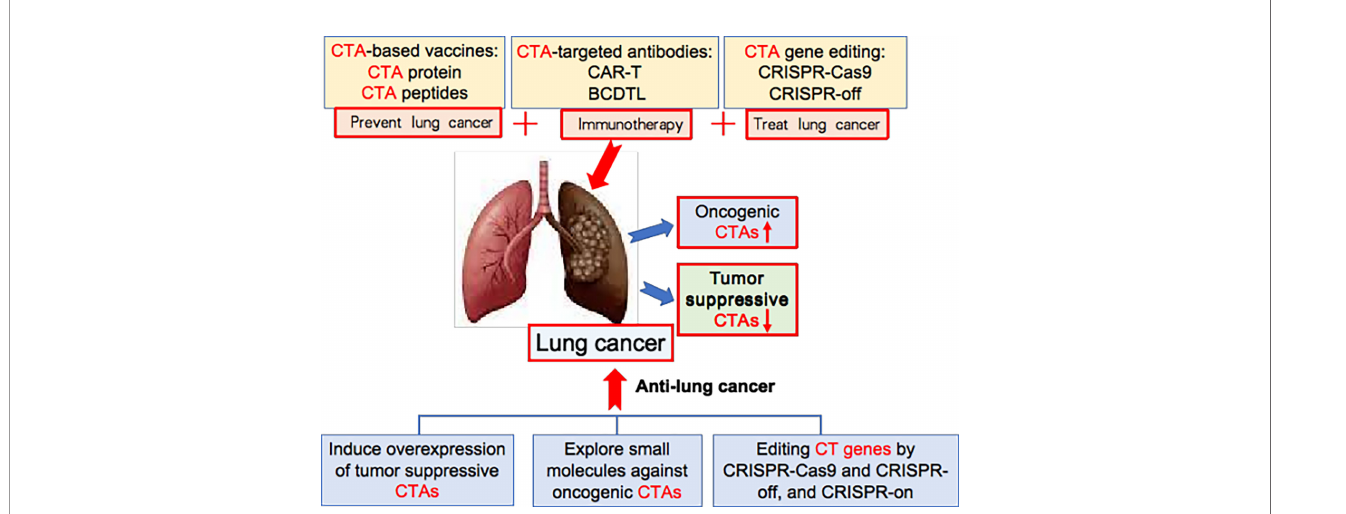
FIGURE 3 | New strategy for CTA-based lung cancer therapy. The oncogenic CTAs are abnormally overexpressed in lung cancer, while tumour-suppressive CTAs are down-downregulated. CTA-based vaccines, CTA-targeted antibodies, and CTA gene editing are new ways for treating lung cancer. Additionally, inducing overexpression of tumour suppressive CTAs, exploring small molecules against oncogenic CTAs, and editing CT genes by CRISPR-Cas9 and CRISPR-off, and CRISPR-on provide new strategy for effective lung cancer